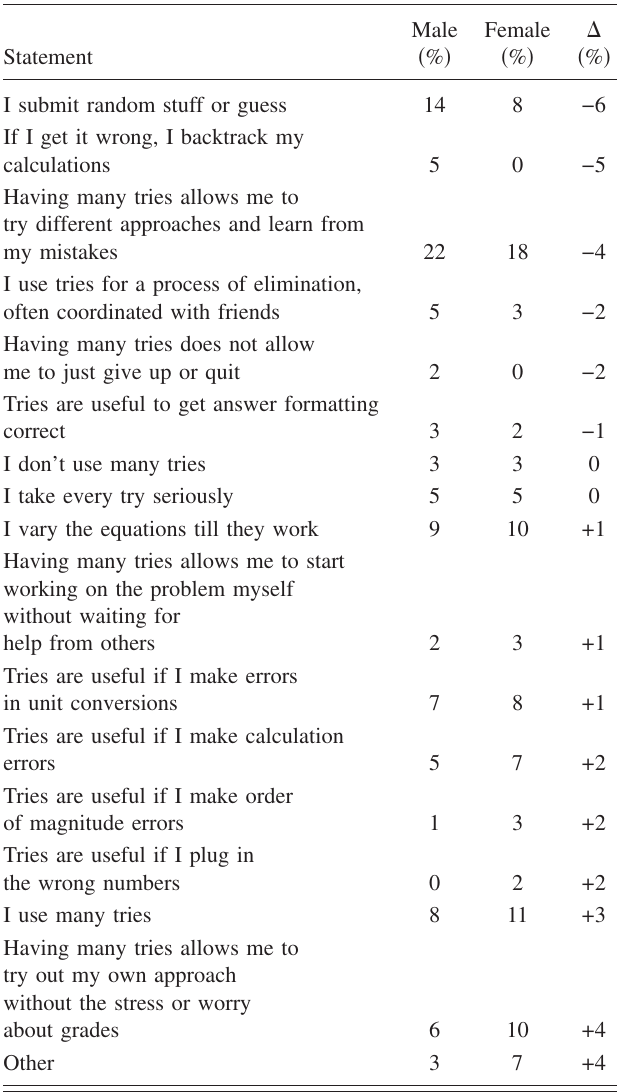
allows me to try out my own approach without the stress or worry about grades.” Apparently, for female students more than for male students, having the possibility to correct mis-